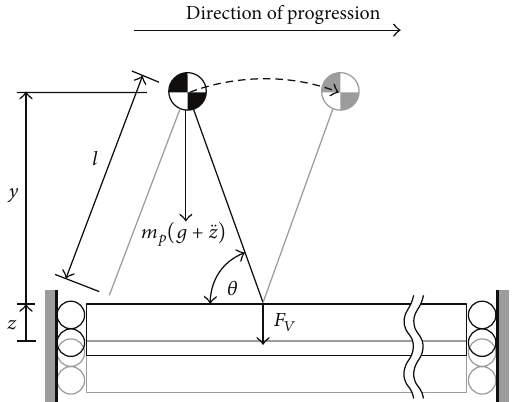
Figure 10: Inverted-pendulum walking human model on a verti- cally vibrating structure